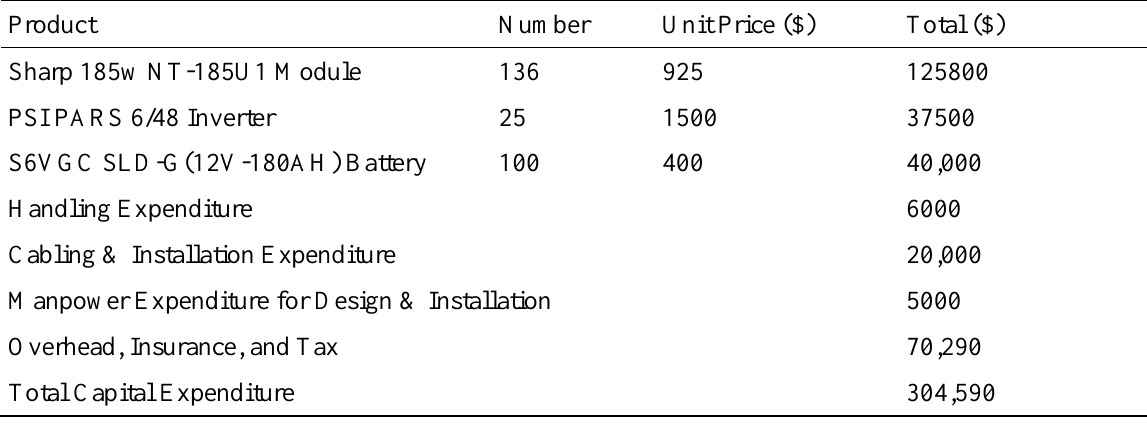
Table 3. Establishment expenditure for network-independent 25 kw photovoltaic plant equipped with battery array to provide the required annual power for RO unit of 32000 kw Product